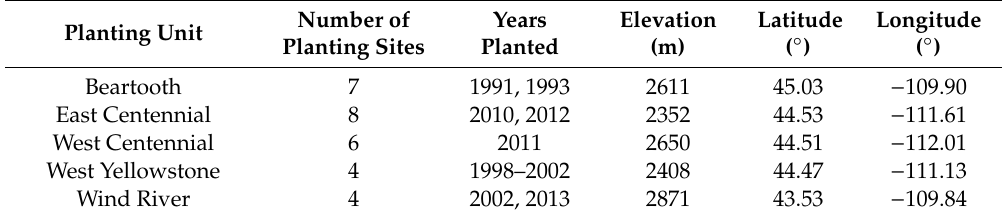
Table 1. Descriptions of planting units. Elevation, latitude, and longitude (NAD83 projection) is an approximate center representing the planting unit centroid.